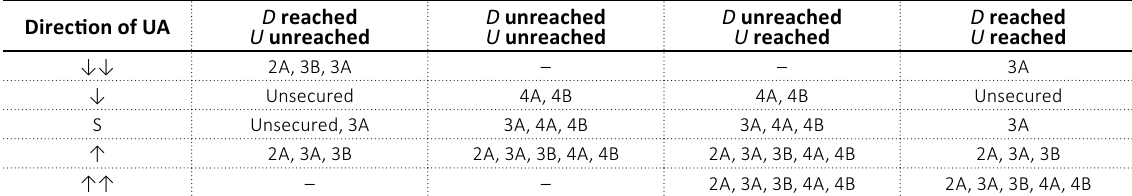
Table 11. An overview of the results from our analysis D reached Direction of UA U